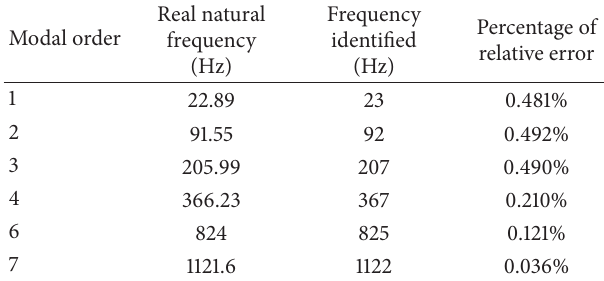
Table7:Errorofnaturalfrequenciesidentifiedbyminimummutual information with gradient descent